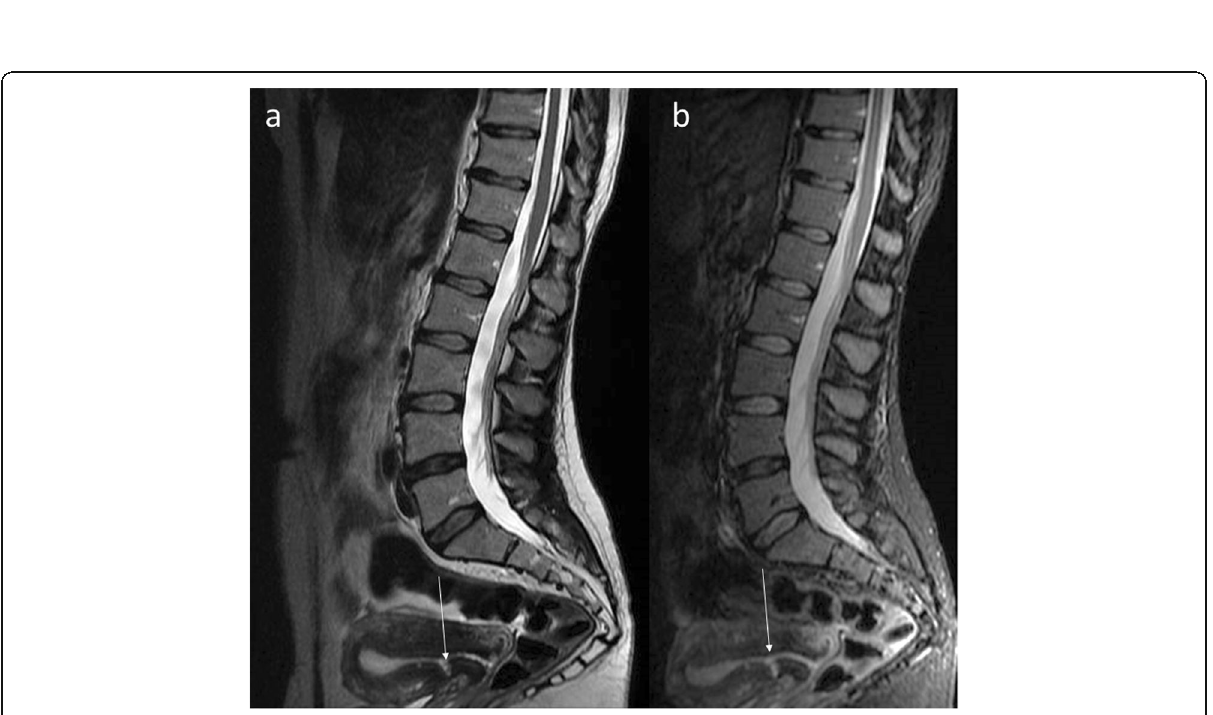
Fig. 4 MRI of the lumbar-sacral part of the vertebral column in the sagittal plane. a FSE/T2WI. b STIR image. Post-C-section niche, hyperintense against the background of the hypointense myometrium, is shown by the